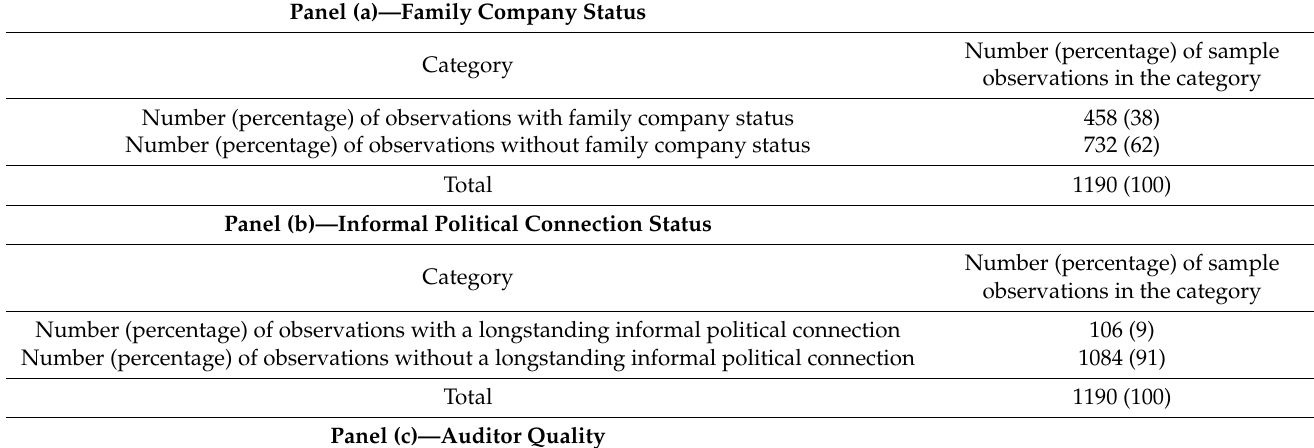
Table 2. Univariate descriptive statistics: categorical